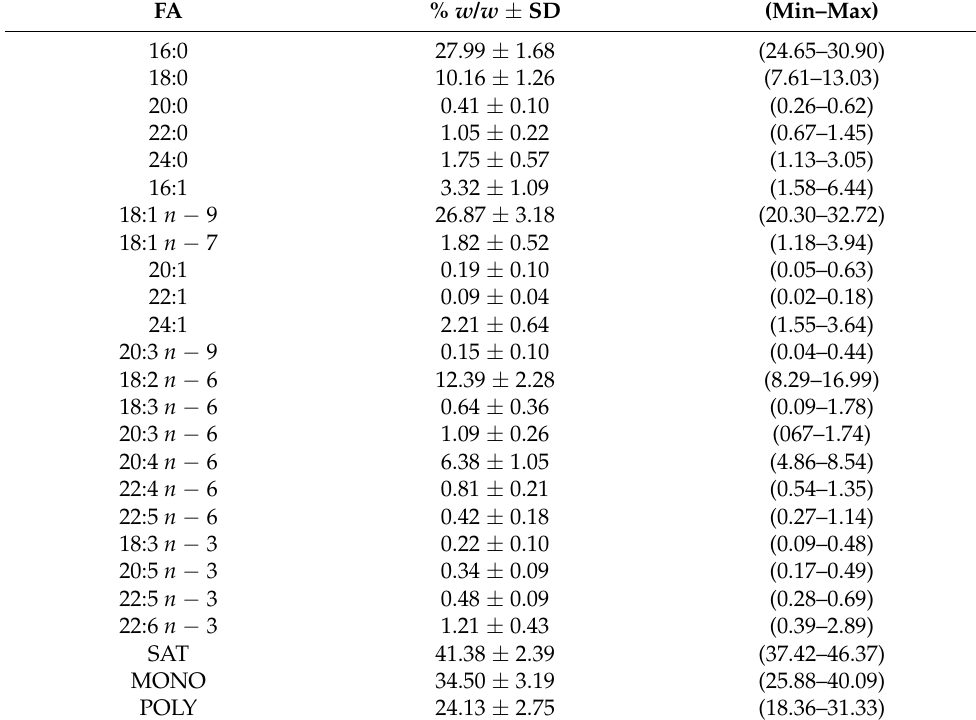
Table 3. Whole blood fatty acid profile in children ( n = 26) with MIS-C. Data are expressed as mean ± standard deviation (SD) of FA of the relative percentage ( weight/weight ) of all FA considered, analyzed as described in